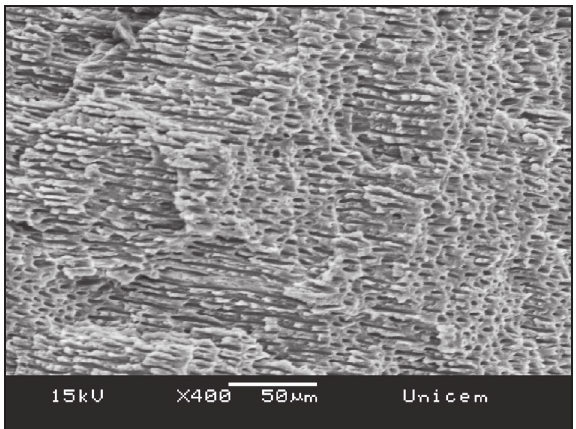
Figure 6 - Cohesive failure within the dentin (type 5) after 6 months of water storage with RelyX Unicem (original mag- nification 400 × ).